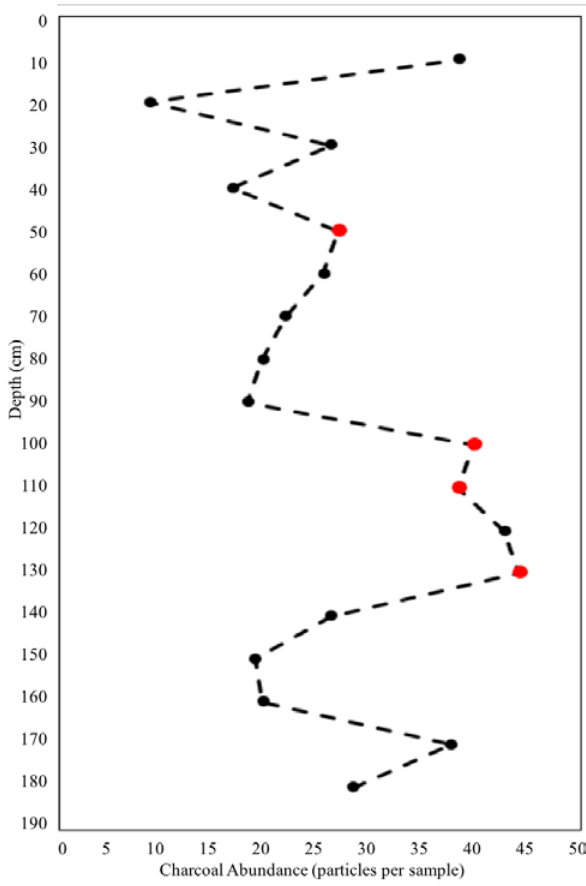
Figure 5. All Saints Bog charred decomposed peat aggregates. Images are from two of the four samples in which evidence of charred peat was found. A: a charred peat aggregate from depth 50–60cm; B: a charred peat aggregate from depth 100–110